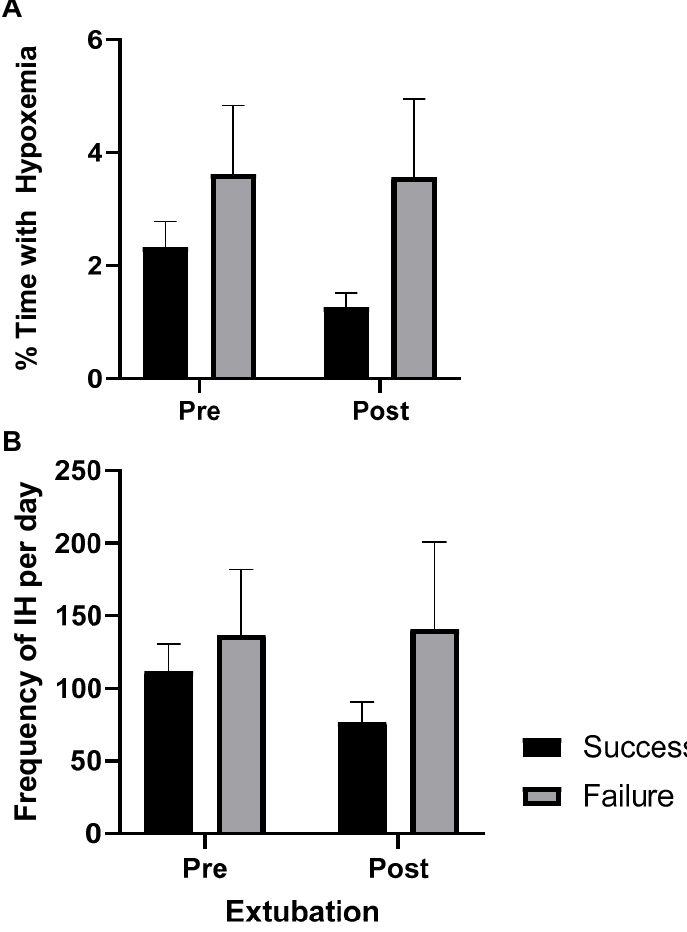
Figure 1. Intermittent hypoxemia (IH) measures 24 h pre- and up to 72 h post-extubation in success and failure groups. ( A ) Percent time in hypoxemia. ( B ) Frequency of IH. Mean ± SE.